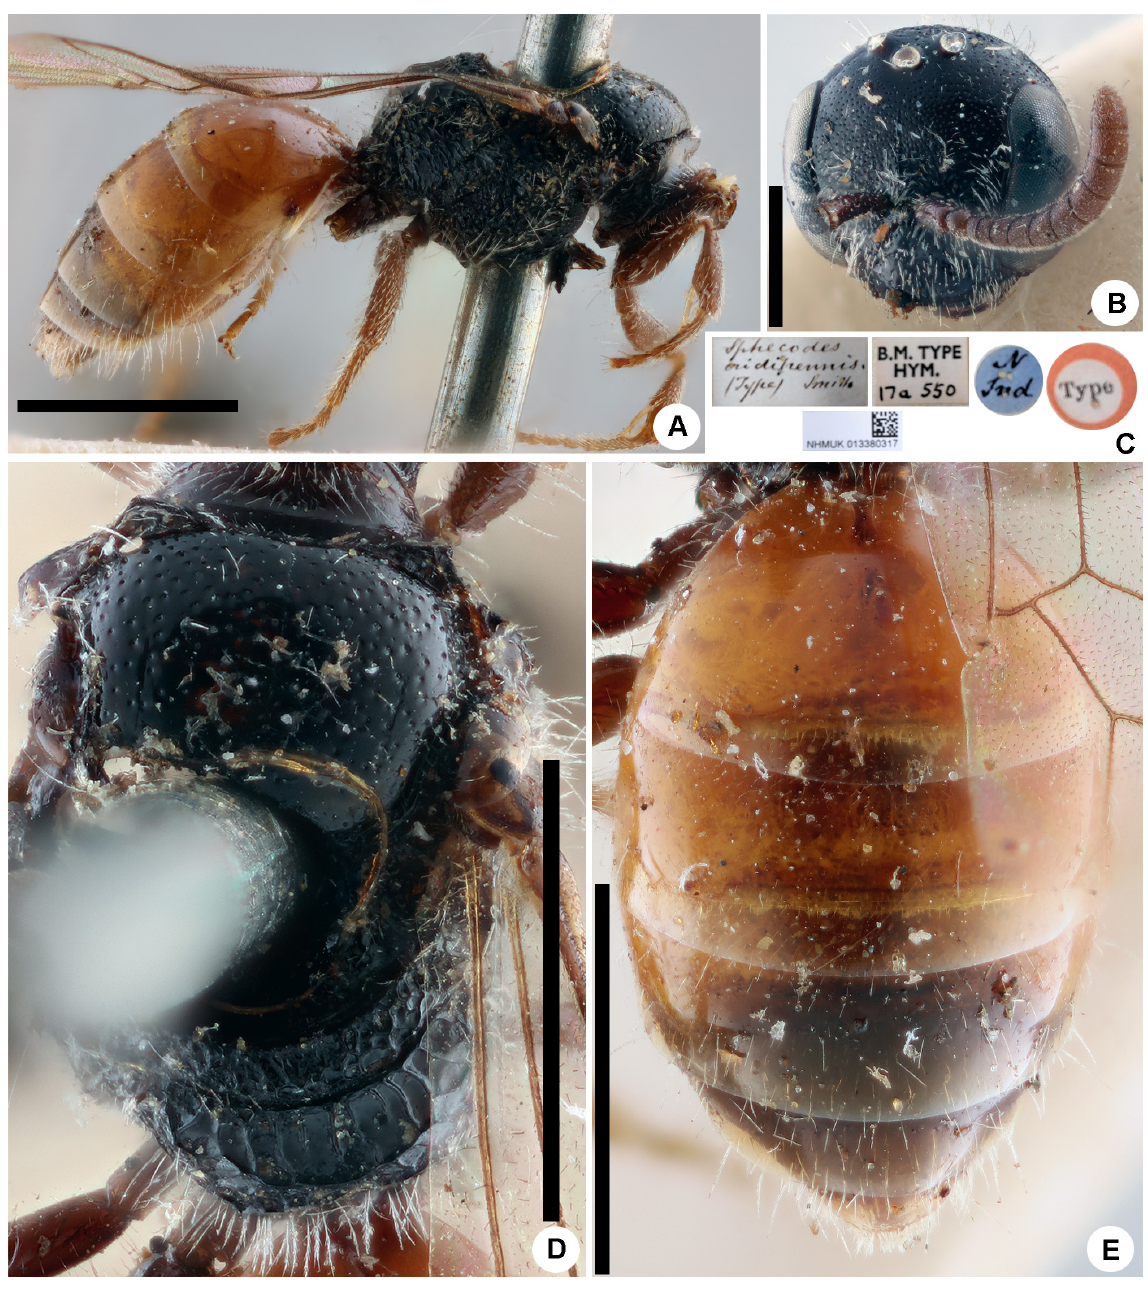
Fig. 11. Sphecodes iridipennis Smith, 1879. Holotype, ♀ (NHMUK 013380317). A . Habitus in lateral view. B . Head in frontal view. C . Labels. D . Mesosoma in dorsal view. E . Metasoma in dorsal view. Scale bars: A, D–E = 1 mm; B = 0.5